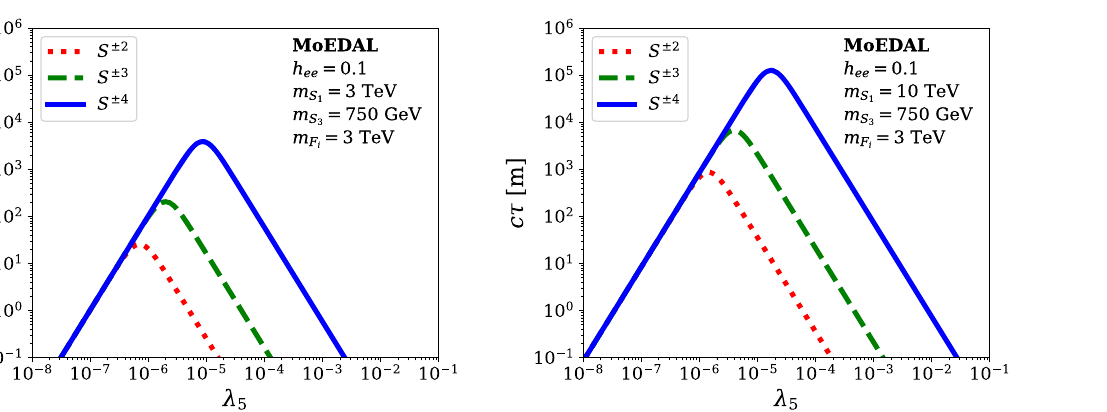
= 750 GeV and m = 3 TeV F i 3